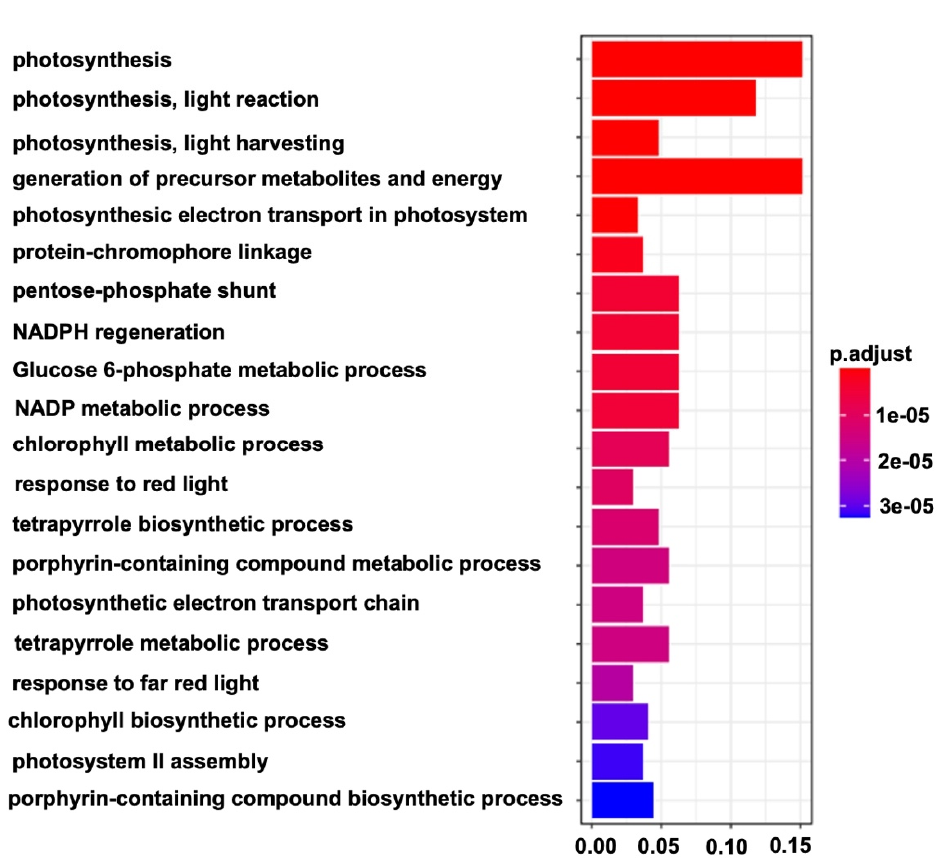
Figure 6. The weighted gene co-expression network analysis (WGCNA) of identified DEGs during the three developmental stages of MR-1 and M4-7. ( A ) Hierarchical cluster tree showing 31 modules of co-expressed genes, where each DEs is represented by a leaf in the tree, and each of the 31 mod- ules is represented by a major tree branch. The lower panel shows modules in designated colors, such as yellow and black. ( B ) The module of the green stigma exhibits correlations and p -values (in parentheses).